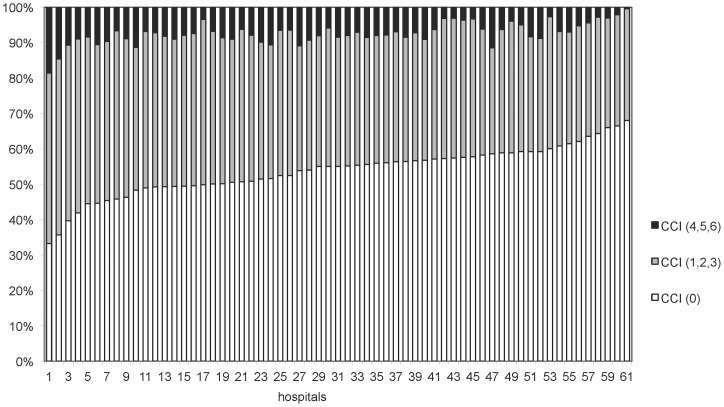
Distribution of the Charlson Comorbidity Index of patients per hospital (for the 50 CCS diagnoses used in calculating HSMR).Distribution of the Charlson Comorbidity index across hospitals. In this figure the Charlson Comorbidity Index groups 1,2 and 3 are aggregated as well as the groups 4,5, and 6.